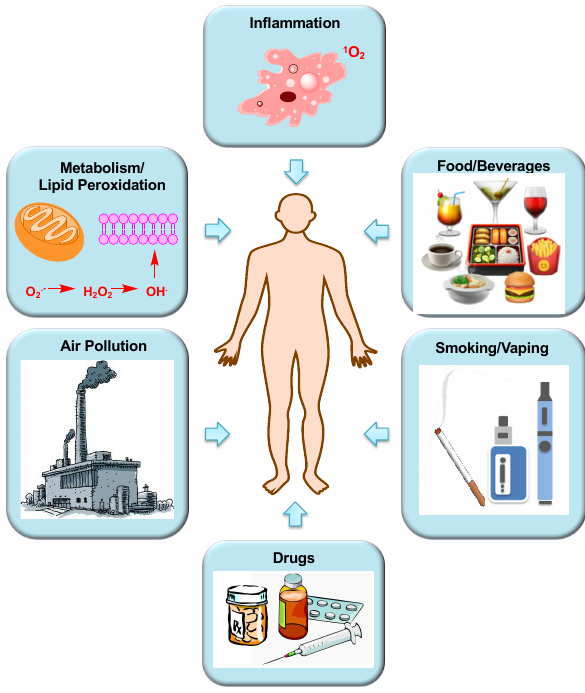
Figure 1. Exogenous and endogenous sources of human exposure to aldehydes.